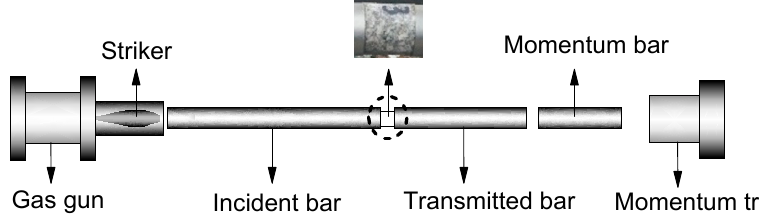
Figure 5. Schematic of the split Hopkinson pressure bar system.